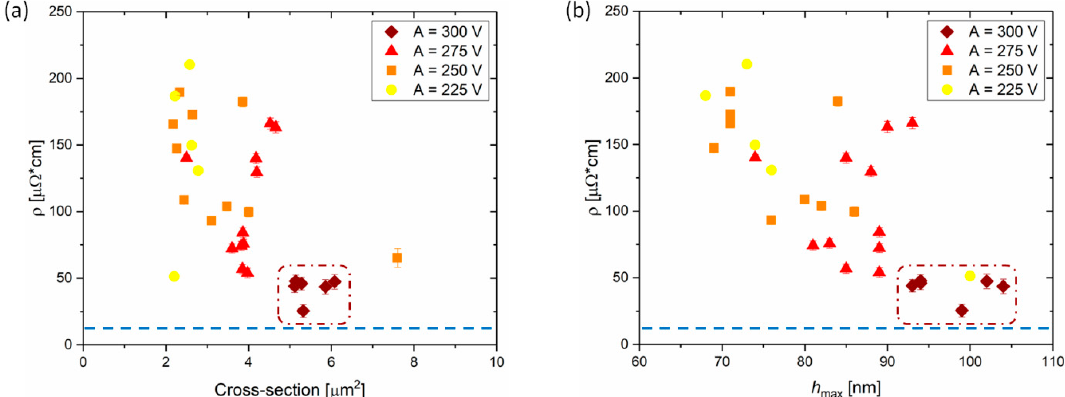
Figure 7. Summary of the resistivity measurements for DGP printed single layer overprints as a function of their cross-section ( a ) and their maximum height ( b ) for different A . The blue dashed lines represent the resistivity reported by the ink supplier.